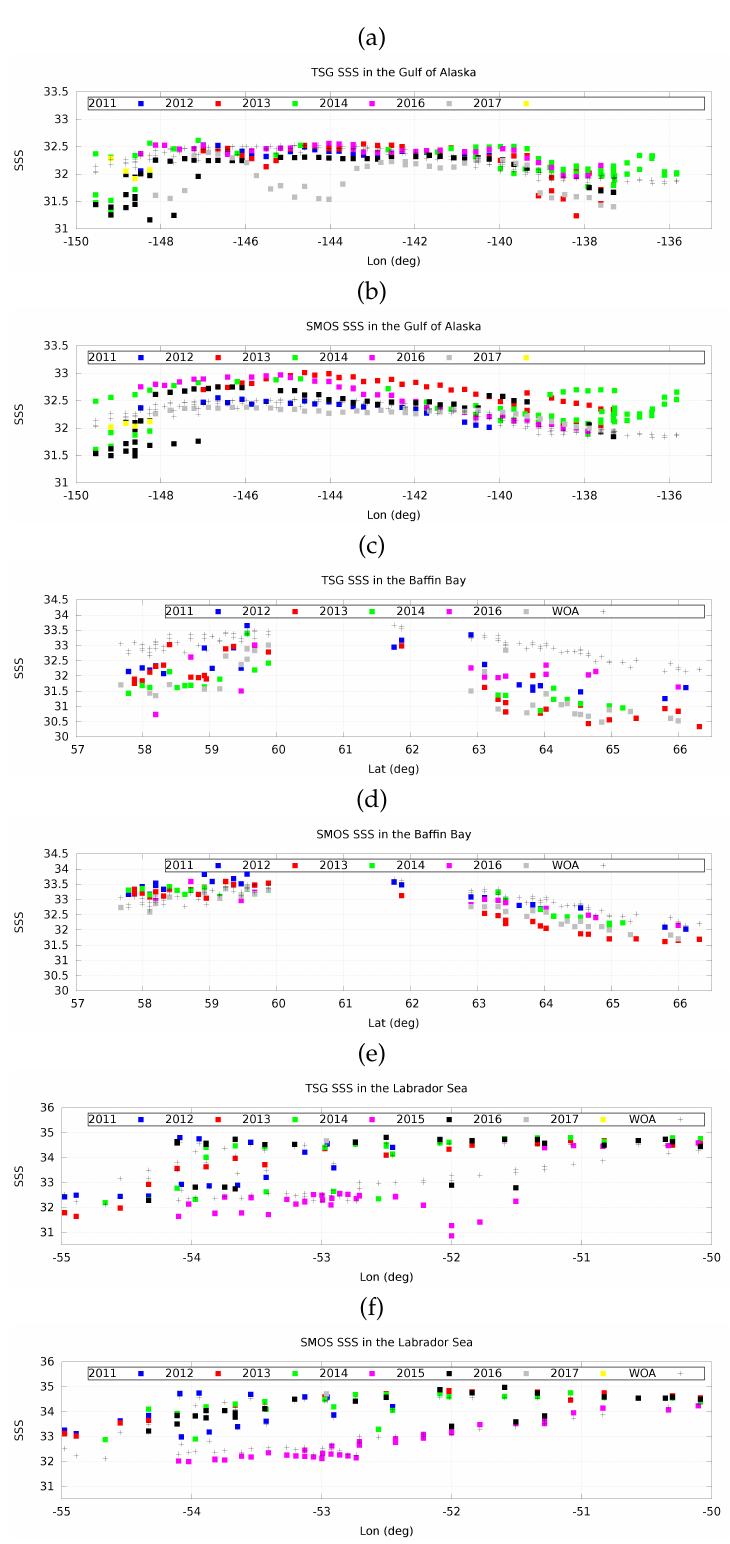
Figure 9. Routinely performed transects during 2011–2017 in: (i) the Gulf of Alaska as observed by TSG (( a ) plot) and SMOS (( b ) plot) in a zonal transect around 58 ◦ N and 150 ◦ W–135 ◦ W; (ii) the Baffin Bay as observed by TSG (( c ) plot) and SMOS (( d ) plot) in a meridional transect around 79 ◦ W and 57 ◦ N–67 ◦ N; and the Labrador Sea as observed by TSG (( e ) plot) and SMOS ((f) plot) in a diagonal transect in the range of latitudes from 50 ◦ N to 60 ◦ N and in the longitude range from 55 ◦ W to 50 ◦